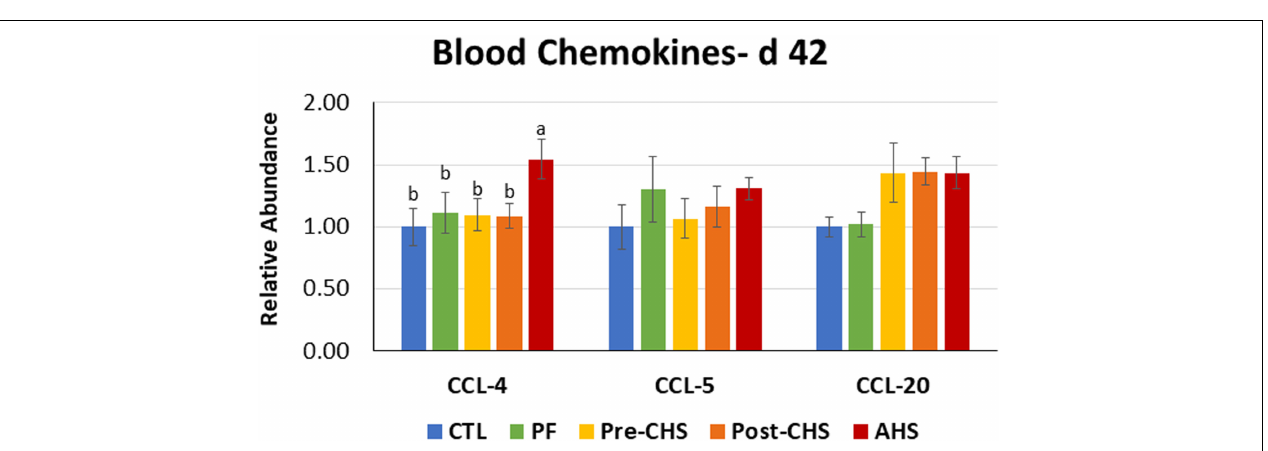
FIGURE 7 | Relative mRNA abundance of C-C motif chemokine ligand ( CCL )- 4 , CCL5 , and CCL20 in the blood of Cobb 500 male broiler chickens on day 42. Birds in all the groups were raised under the recommended conditions from day 0 to 28. Treatments include: (1) control (CTL): birds raised under thermoneutral condition (23 ◦ C) from day 29 to 42; (2) AHS: birds raised under thermoneutral condition (23 ◦ C) from day 29 to 42, but exposed to 2 h AHS (35 ◦ C) before sampling on day 42; (3) Pre-CHS: birds exposed to high ambient temperature (35 ◦ C) for 8 h/day (9:30 am–5:30 pm) from day 29 to 42, and sampled before starting the CHS; (4) Post-CHS: birds exposed to high ambient temperature (35 ◦ C) for 8 h/day (9:30 am–5:30 pm) from day 29 to 42, and sampled 2 h after starting the CHS; (5) pair-fed (PF): birds raised under thermoneutral condition (23 ◦ C) from day 29 to 42, but pair-fed to CHS group (these birds received each day 1.05 times the average feed intake recorded in the CHS group in the previous day). Values are represented as a n -fold difference relative to the calibrator (CTL). Results are given as means ( n = 8) for each group. Error bars indicate standard errors. For each gene, bars with different letters are significantly different ( P <